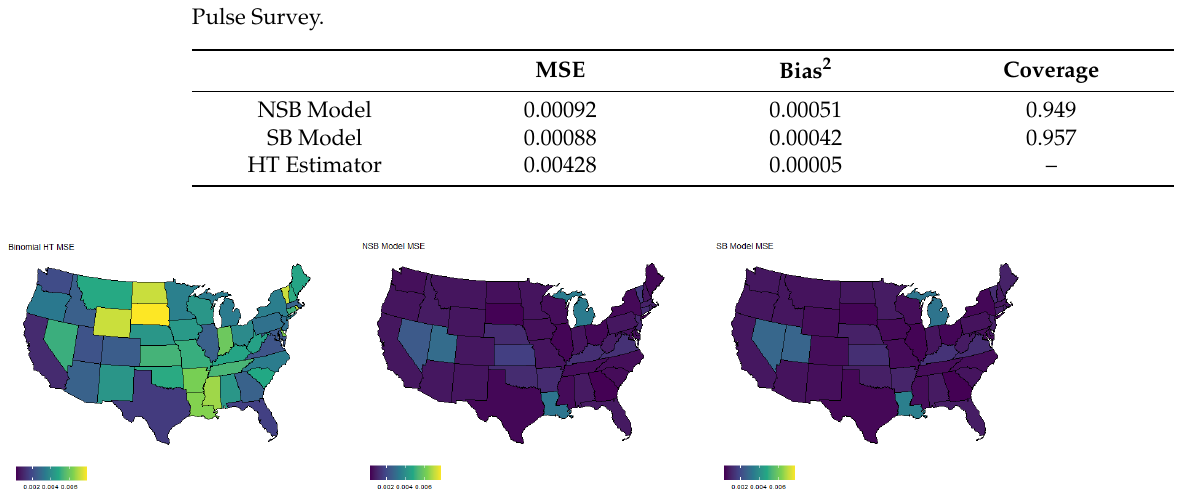
Figure 1. Map of MSE by state for each estimator. Data are based on the binomial simulation using Week 1 of the Household Pulse Survey. The response variable used is the expected loss of job and/or income in the next week.